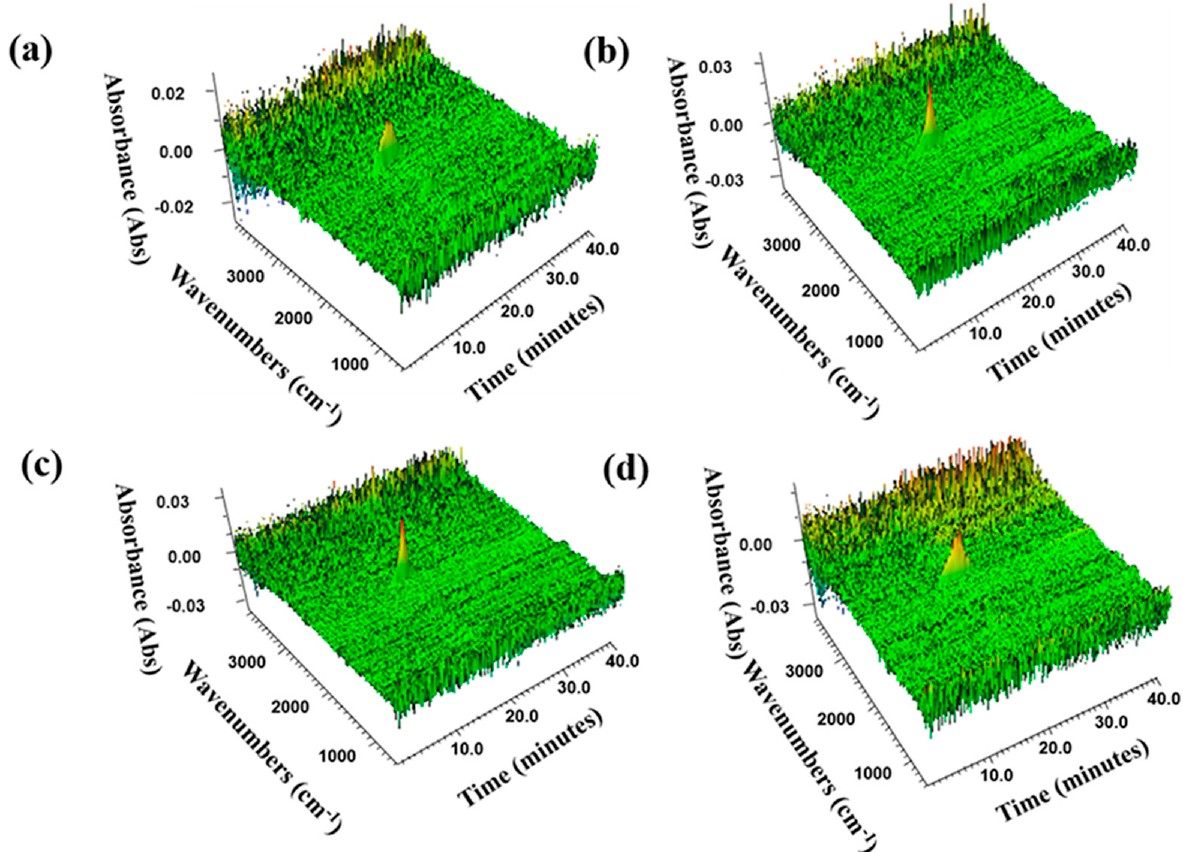
Figure 5. TG-FTIR 3D images of RPUF and RPUF-R composites: ( a ) RPUF; ( b ) RPUF-1; ( c ) RPUF-3; ( d ) RPUF-5.